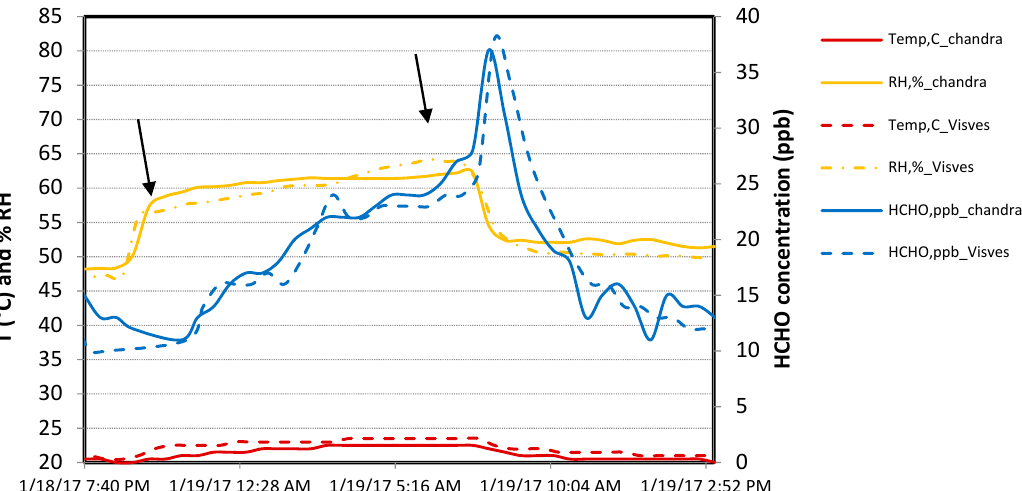
Figure 10. Comparative T, RH, and HCHO concentrations in Visvesvaraya and Chandrasekhar; the arrows indicate the switching off and on of the HVAC system.